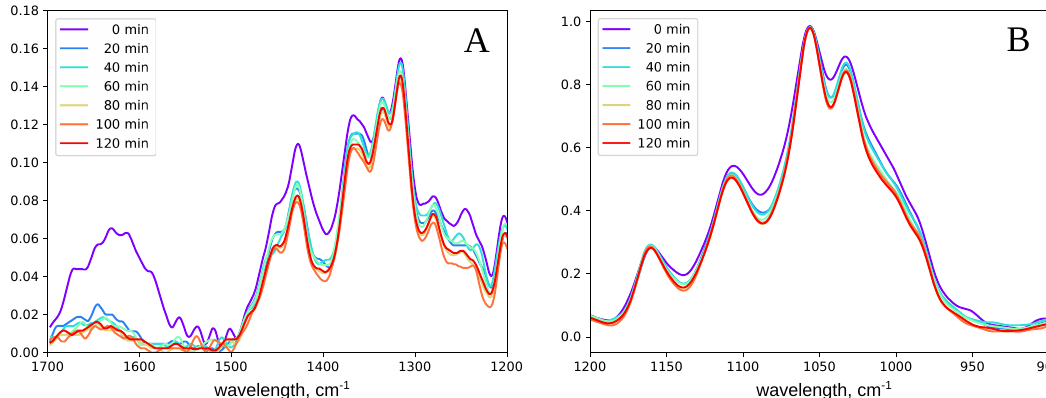
Figure 4. Changes in the IR spectra of cotton cellulose in the course of the acid hydrolysis. The spectrum was split into two parts: 1700–1200 cm − 1 ( A ) and 1200–900 cm − 1 ( B ).